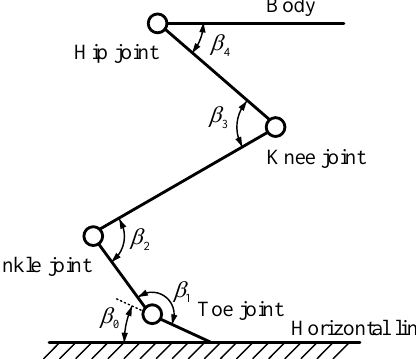
Figure 6. Schematic of joints of hind limbs of flying squirrel.